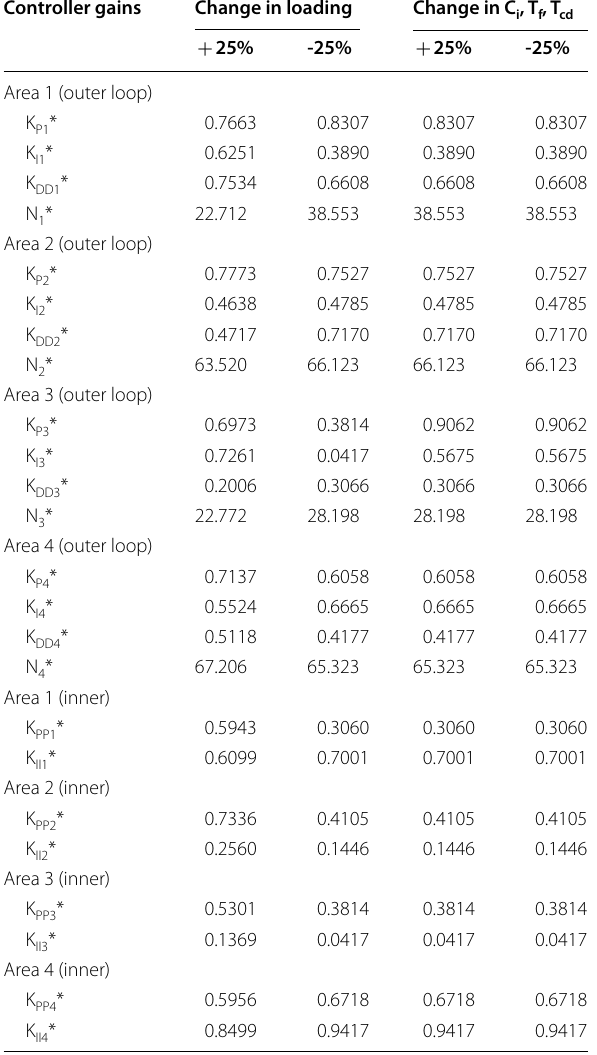
Table 7 Optimum controller gains and parameters for change in system loading, generating unit